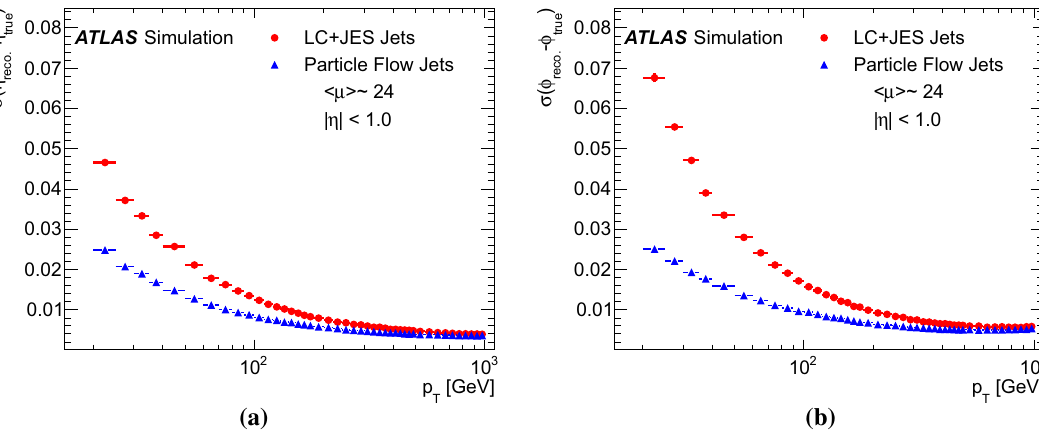
Fig. 28 The angular resolution, a in η and b in φ , as a function of the jet p T , determined in dijet MC simulation by fitting Gaussian functions to the difference between the reconstructed and truth quantities. Conditions are similar to the data-taking in